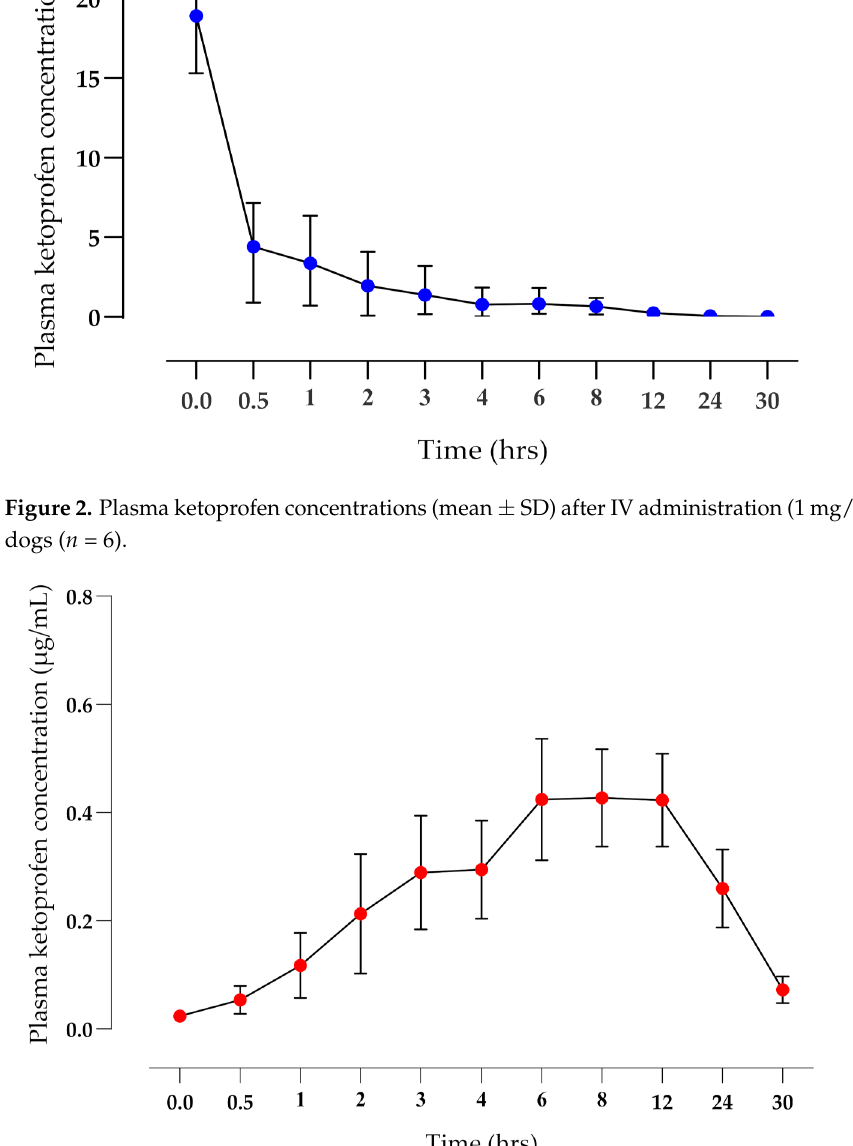
Figure 3. Plasma ketoprofen concentrations (mean ± SD) after TDK application (10 mg/kg) to healthy dogs ( n =